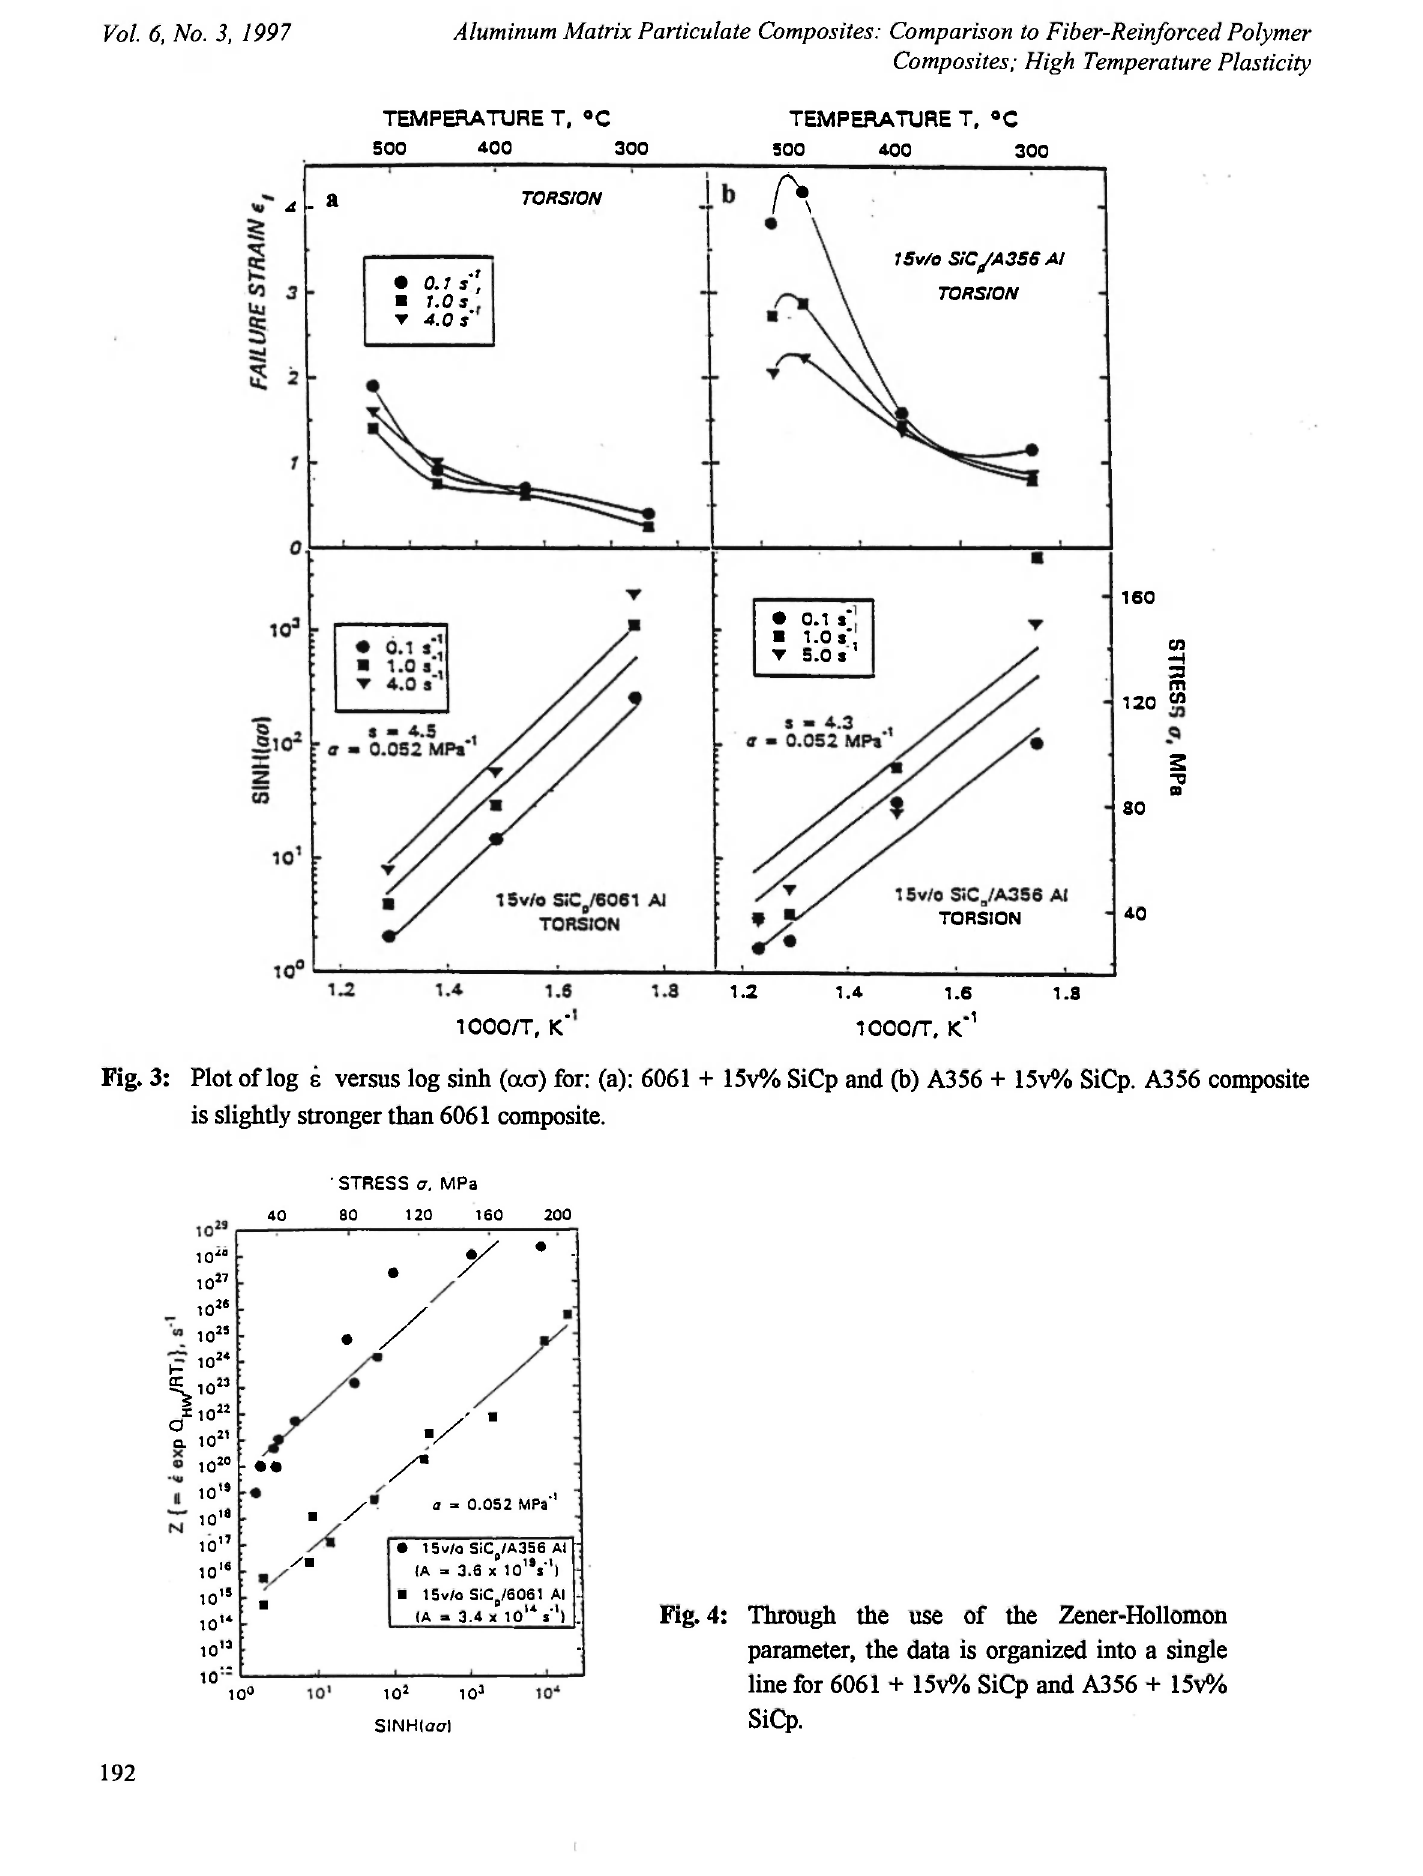
Fig. 3: Plot of log έ versus log sinh (ασ) for: (a): 6061 + 15v% SiCp and (b) A356 + 15v% SiCp. A356 composite is slightly stronger than 6061 composite.